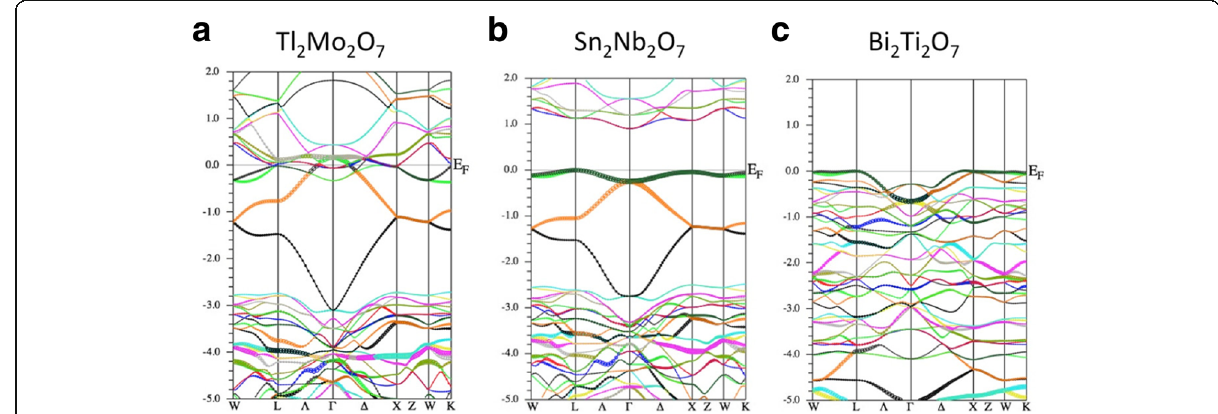
Fig. 2 Electronic band structure of ( a ) Tl 2 Mo 2 O 7 , ( b ) Sn 2 Nb 2 O 7 , and ( c ) Bi 2 Ti 2 O 7 . The unit of energy is